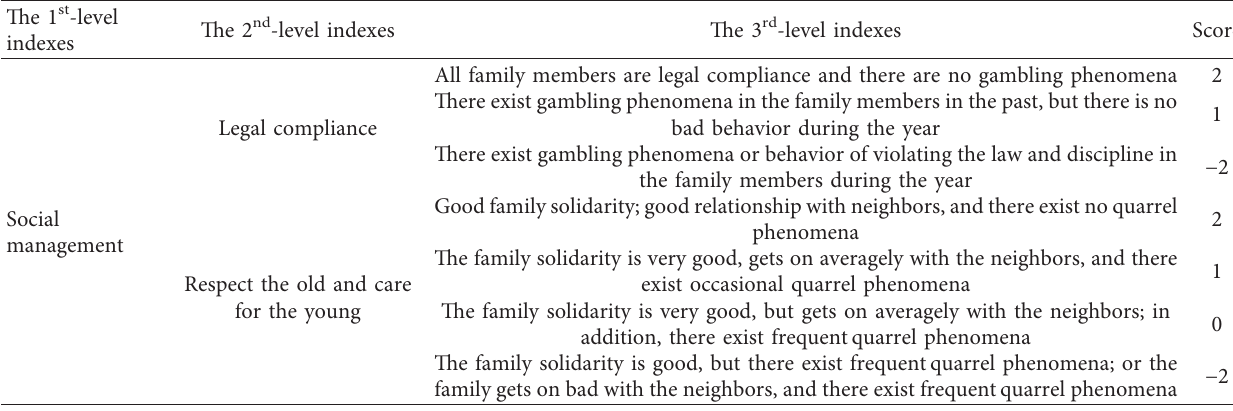
Table 3: The 3 rd -level indexes under the legal compliance and their scores.